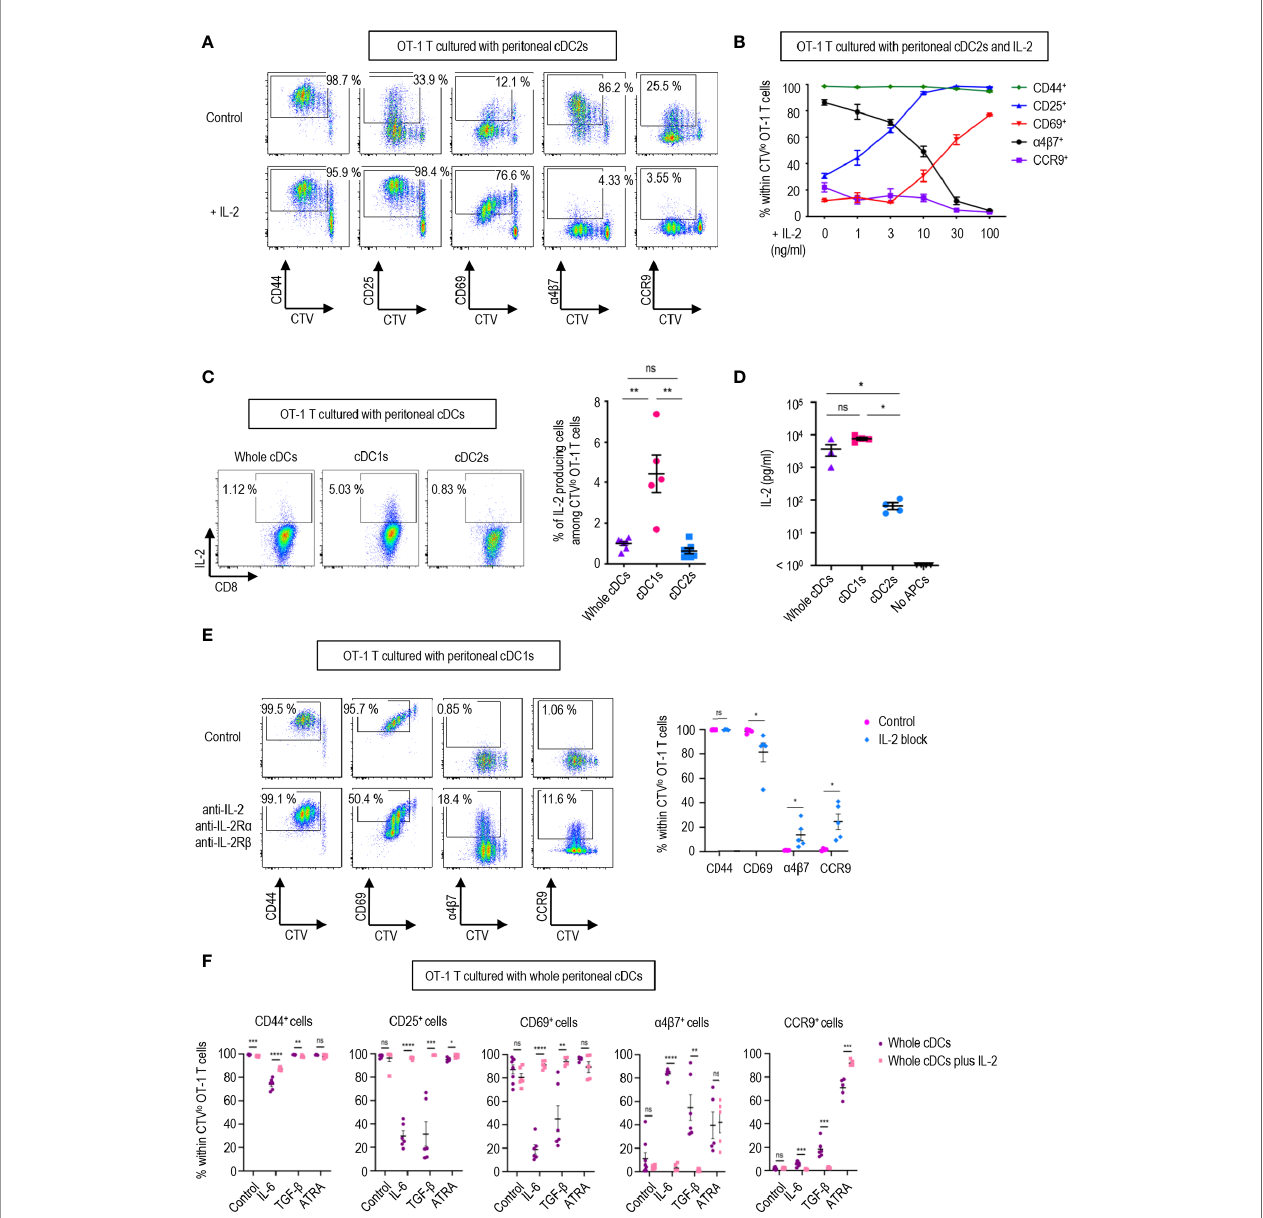
FIGURE 3 | IL-2 produced by CD8 T cells regulates T cell responses. 1.5 mg of OVA (Grade V) was injected into the peritoneal cavity for an hour. OVA-laden peritoneal cDC subsets were sorted and co-cultured with naïve OT-1 T cells for 3 days before analysis. (A) Expression of CD44, CD25, CD69, a 4 b 7, and CCR9 molecules on OT-1 T cells stimulated by peritoneal cDC2s with or without 100 ng/ml of IL-2 for 3 days. Live CTV lo CD8 + T cells are plotted and the percentages of cells expressing each molecule among CTV lo proliferated OT-1 T cells are denoted (representative of more than 5 independent experiments). (B) Effect of graded doses of IL-2 on OT-1 T cells. OT-1 T cells were co-cultured with peritoneal cDC2s with the indicated doses of IL-2 for 3 days. The percentages of cells expressing each molecule among CTV lo proliferated OT-1 T cells are shown in a graph. Data are pooled from more than 3 independent experiments (n = 3). (C) Intracellular staining of IL-2. OT-1 T cells were stimulated by peritoneal cDCs for 3 days, and treated with Brefeldin A for the last 4 hours. Live CTV lo CD8 + cells are plotted and the percentages of OT-1 T cells expressing IL-2 among CTV lo proliferated OT-1 cells are shown in a graph. Data are pooled from 2 independent experiments (n = 5). (D) IL-2 was measured by ELISA from the supernatant collected from OT-1 T cells stimulated by peritoneal cDCs for 3 days (n = 4). (E) Expression of CD44, CD69, a 4 b 7, and CCR9 molecules on OT-1 T cells stimulated by peritoneal cDC1s while blocking IL-2 signaling. OT-1 T cells and peritoneal cDC1s were co-cultured with antibodies blocking IL-2 signaling (2 m g/ml of polyclonal anti-IL-2, 10 m g/ml of PC61 anti-IL-2R a , and 10 m g/ml of TmB1 anti-IL-2R b ) for 3 days. Live CTV lo CD8 + T cells are plotted and the percentages of cells expressing each molecule among CTV lo proliferated OT-1 T cells are shown in a graph. Data are pooled from 3 independent experiments (n = 5). (F) Effect of IL-2 and other immunomodulating molecules. OT-1 T cells and peritoneal whole cDCs were co-cultured with or without 1 µg/ml of IL-2 under speci fi ed conditions (20 ng/ml of IL-6, 6 ng/ml of TGF- b , or 20 µM of ATRA). The percentages of cells expressing each molecule among CTV lo proliferated OT-1 T cells are shown in graphs. Data are pooled from 2 independent experiments (n ≥ 5). Error bars (B – F) indicate mean ± SEM. *p<0.05; **p<0.01; ***p<0.001; ****p<0.0001; ns, statistically not signi fi